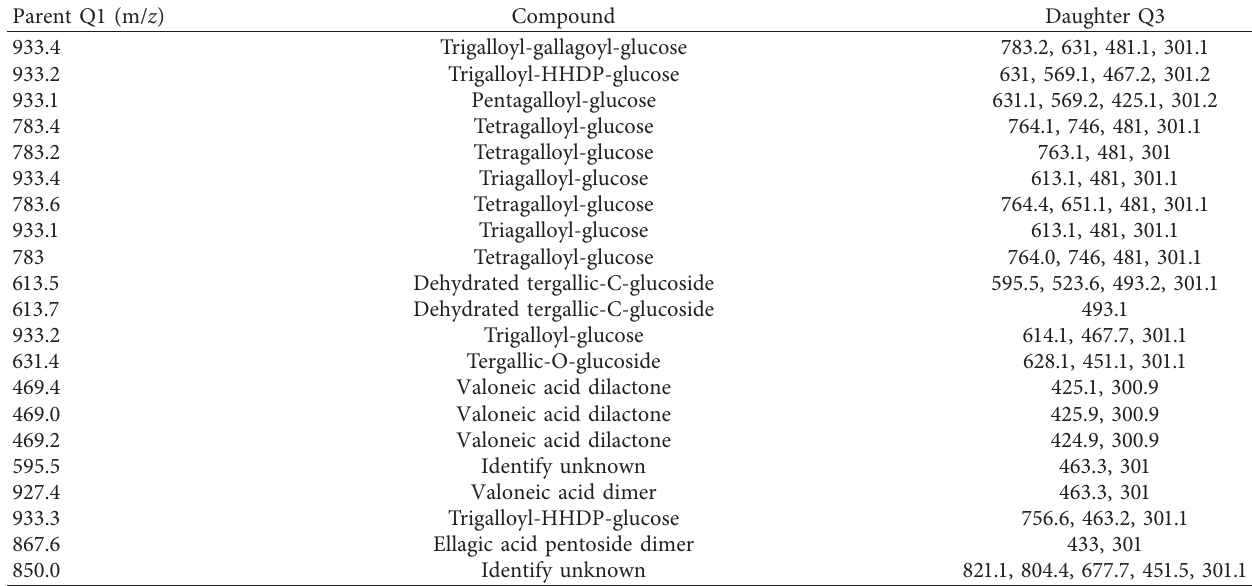
Table 2: Selected group of gallotannins and ellagitannins screened by enhanced MS using the LIT. Parent Q1 (m/ z